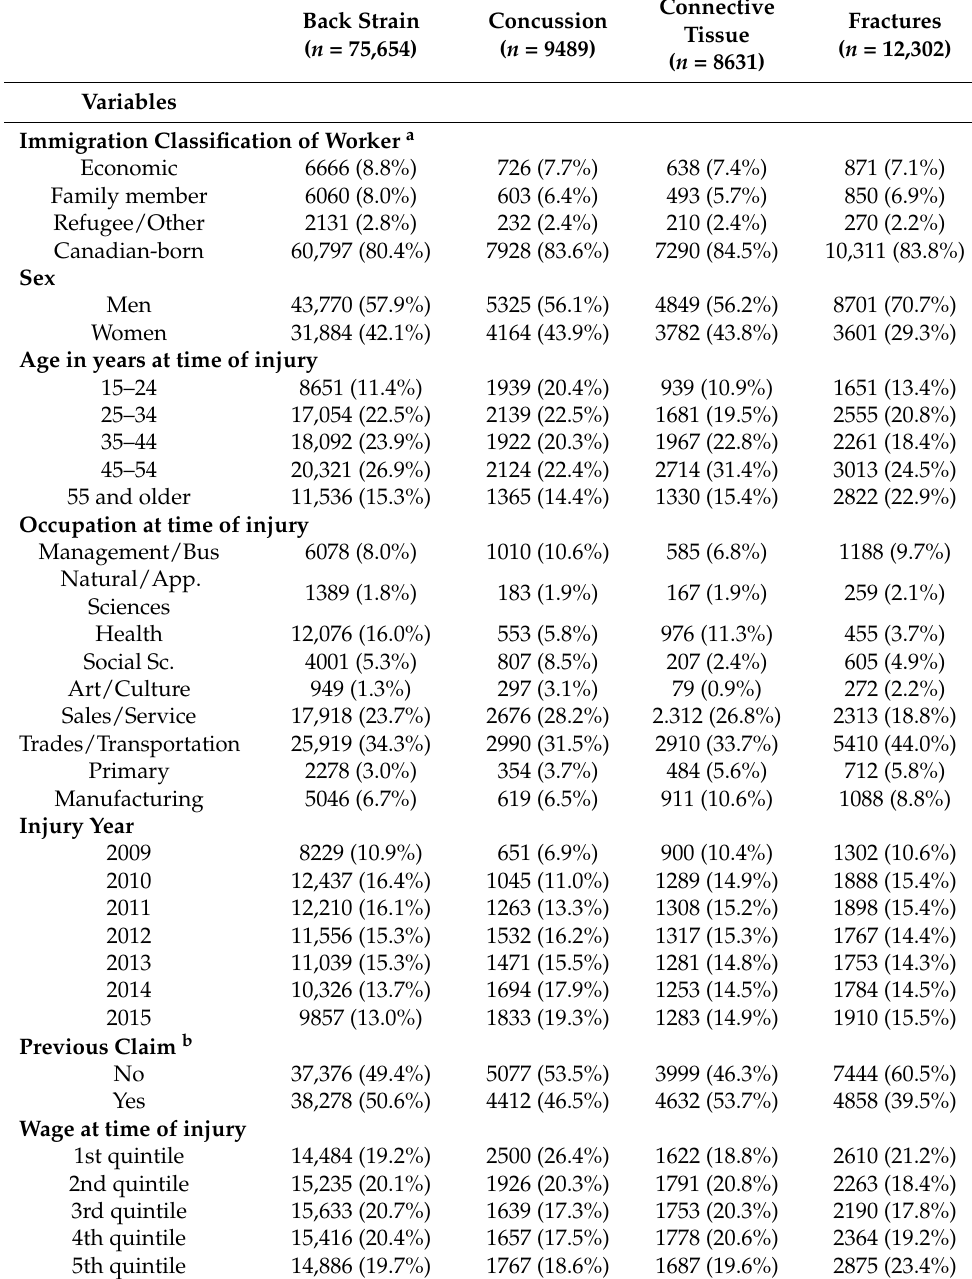
Table 1. Sociodemographic and socioeconomic characteristics of injured workers who had an accepted workers’ compensation between 2009 and 2015, by injury